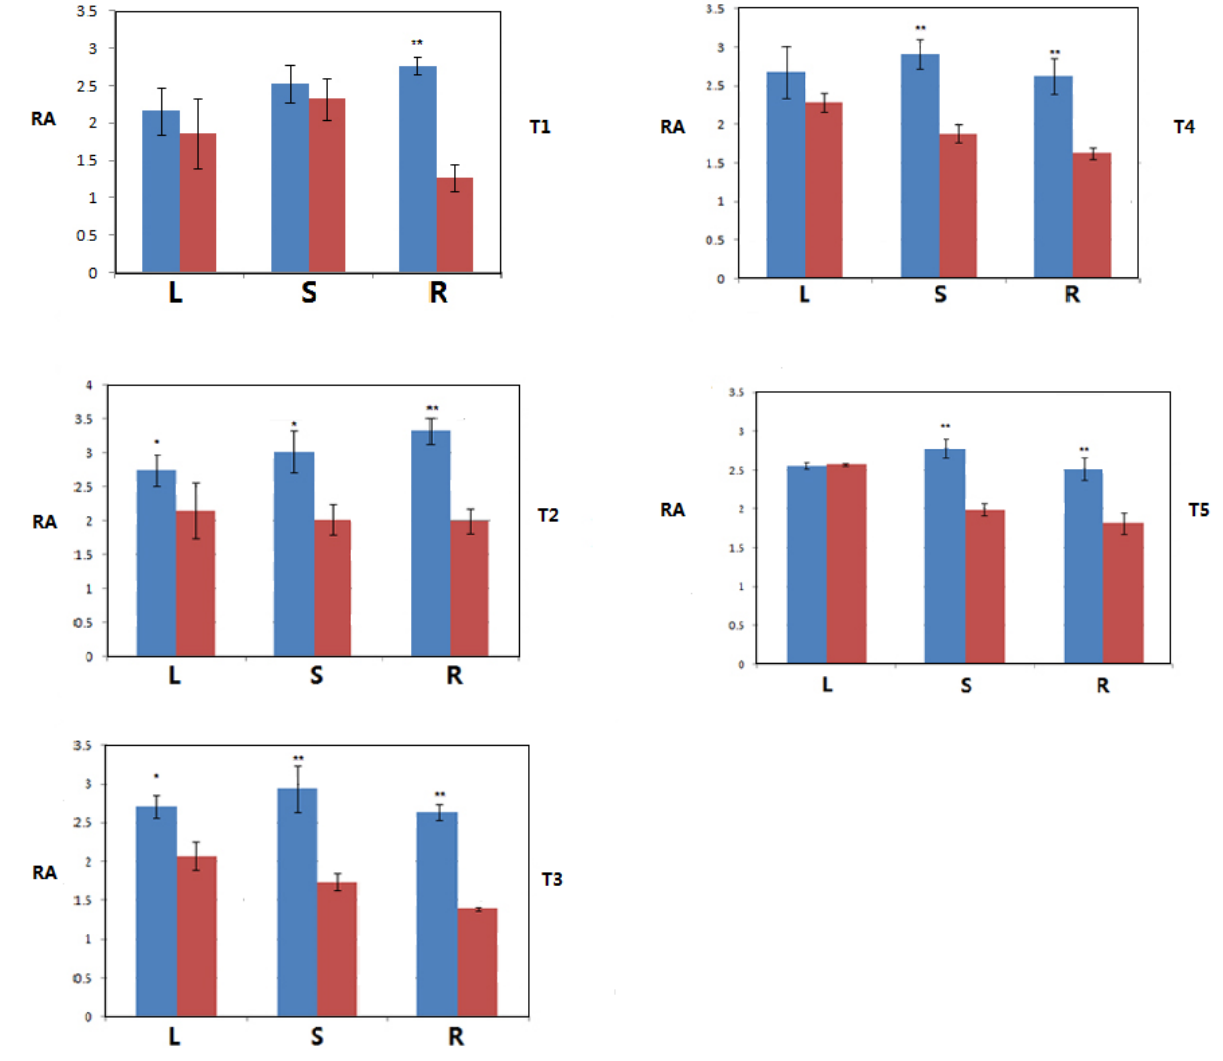
Figure 4. Analysis of AhDREB 1 expression in different organs from five transgenic poplars in 2009 (blue) and 2013 (red). The transcriptional expression level of AhDREB 1 in 2013 was slightly (* 0.01 < p < 0.05, α = 0.05) or significantly (** p < 0.01, α = 0.05) decreased compared with